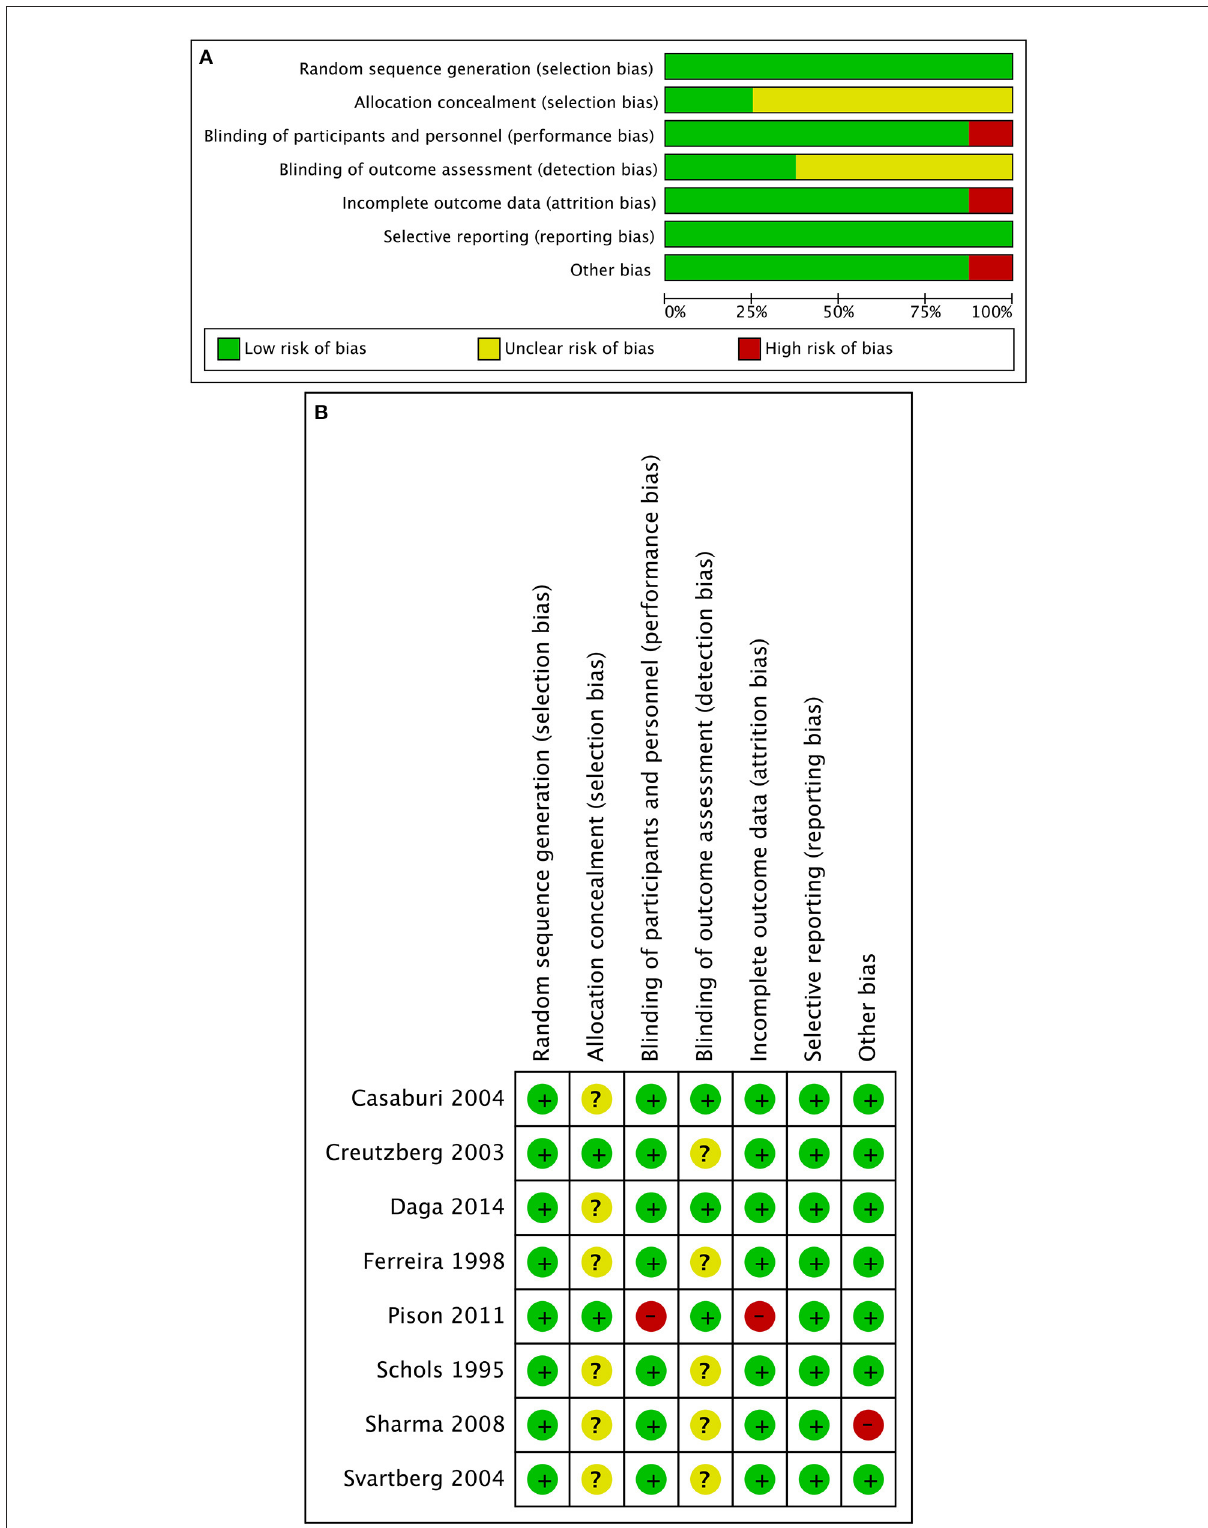
FIGURE2 Quality assessment of included randomized control trials. (A) Risk of bias graph judging by Cochrane risk-of-bias tool. (B) Risk of bias summary. Insufficient details were reported about allocation concealment of the studies by Casaburi 2004 and Daga 2014. Insufficient details were reported about allocation concealment and outcome assessors of the studies by Ferreira 1998, Schols 1995, and Svartberg 2004. Insufficient details were reported about outcome assessors of the study by Creutzberg 2003. Blinding can be difficult, and the rate of lost to follow-up was more than 10% in the study by Pison 2011. Insufficient details were reported about allocation concealment and outcome assessors of the study by Sharma 2008, and the study was discontinued following the interim